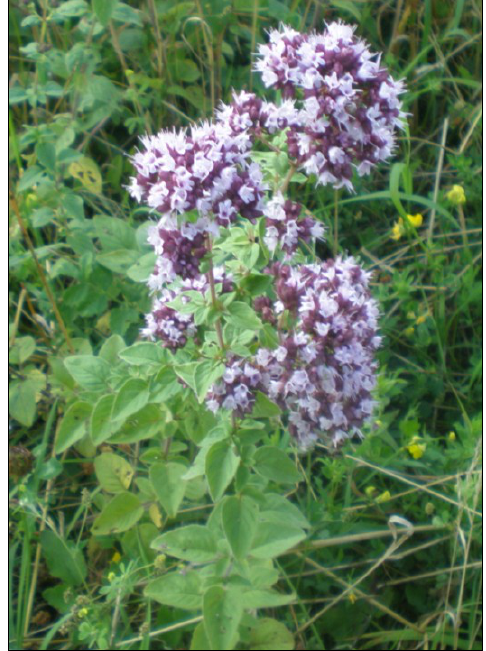
Figure 1. Origanum vulgare L. in flowering